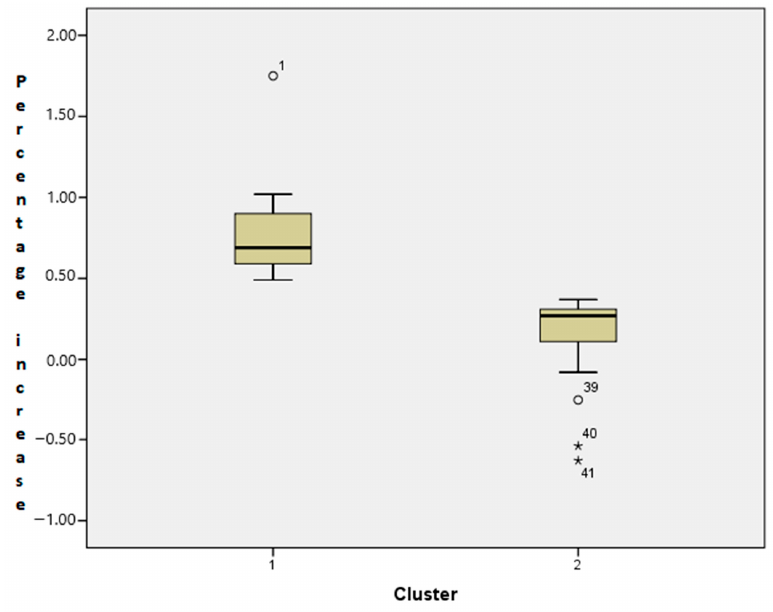
Figure 3. Box-plot cluster. Source: own processing using SPSS software.